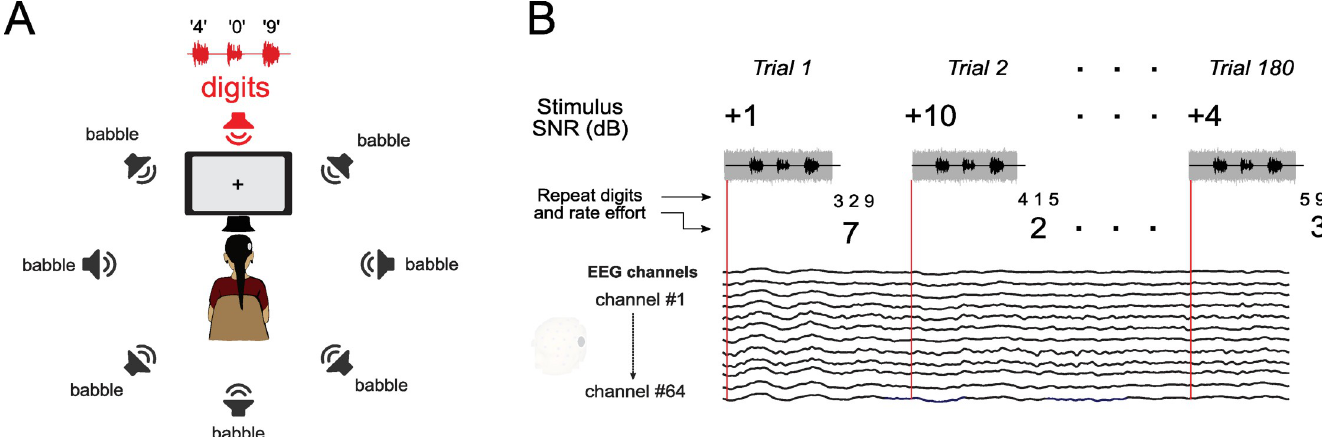
Fig 1. Experimental design. A) Participants were presented with triplets of digits spoken by a female talker at the front-facing speaker, while multi-talker babble noise of varying SNR was presented in the seven peripheral speakers. B) During EEG recording, trials of the digit triplet test were presented, with SNR varying on each trial. After the stimulus presentation ended, participants reported the digits they perceived as well as their listening effort rating on a 1–10 verbal report scale.